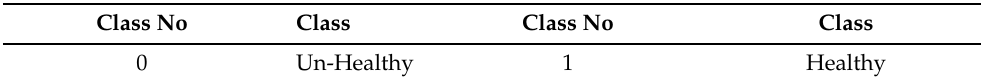
Figure 5. Selected image with unhealthy tag. Table 3. Dataset